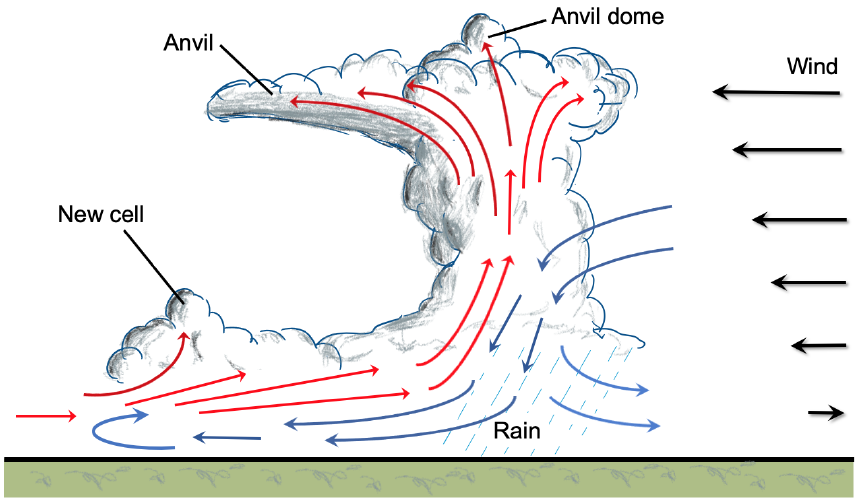
Figure 11. Schematics of a terrestrial multicell convective storm. The structure of the storm and the motion of the hot (red) and cold (blue) air parcels are mainly defined by the strength of the convection and the wind shear. The vertical shear also causes the anvil to be advected downstream. Upon reaching the surface the downdraft turns into an outflow that can trigger new cells after colliding with warm and moist air outside of the original cell. The momentum of the rising air parcel carries parts of the plume beyond the equilibrium level (EL) and creates an anvil dome. This feature most often triggers gravity waves that affects the appearance of the clouds when viewed from